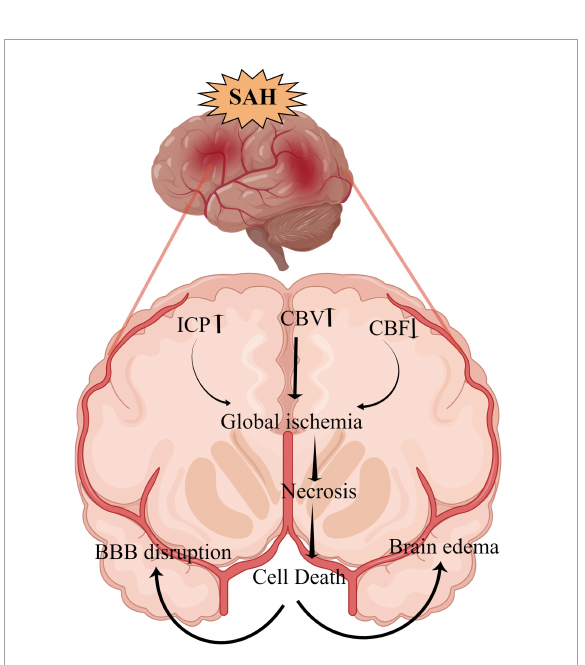
FIGURE1 The overall scheme of neuronal necrosis from subarachnoid hemorrhage to early brain injury